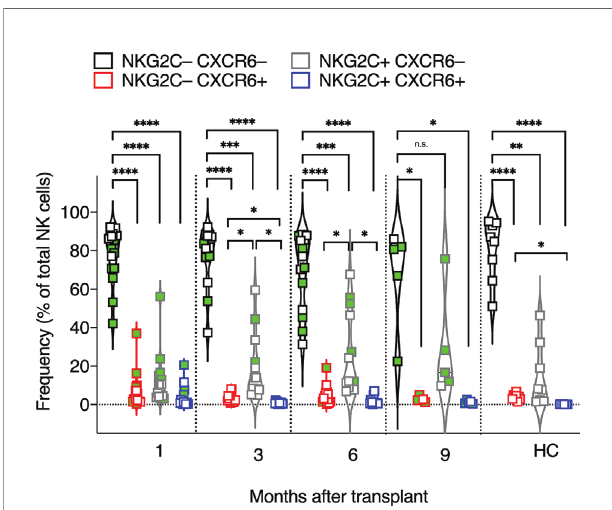
FIGURE 3 | Frequencies of CXCR6 + , NKG2C + , CXCR6 – NKG2C – , and CXCR6 + NKG2C + NK cells. The frequencies of CXCR6 + , NKG2C + , CXCR6 – NKG2C – , and CXCR6 + NKG2C + NK cells were determined for each patient ’ s circulating NK cells at indicated time points using fl ow cytometry. Circulating healthy adult donor NK cells were also analyzed as a control. Each data point represents a single patient or healthy adult control donor (HC). Data points with a neon-green fi ll color represent patients positive for CMV up to and at the analysis time as determined by quantitate PCR. *p <0.05; **p < 0.005; ***p < 0.0005; ****p <0.0005; Not signi fi cant